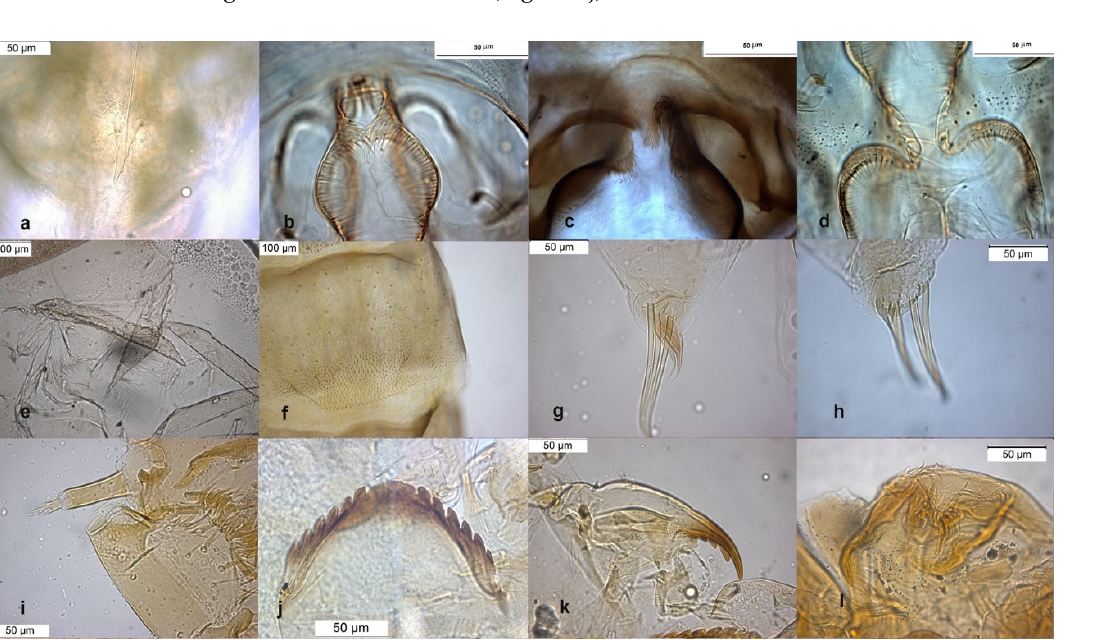
Figure 3. Morphological characters of O. oblidens adult male: ( a ) anal point; ( b ) virga; ( c ) superior volsella; ( d ) inferior volsella; pupal exuvia: ( e ) thoracic horn, ( f ) tergite III; ( g ) taeniate extensions; ( h ) anal macrosetae; larva: ( i ) antenna; ( j ) mentum; ( k ) mandible; ( l )